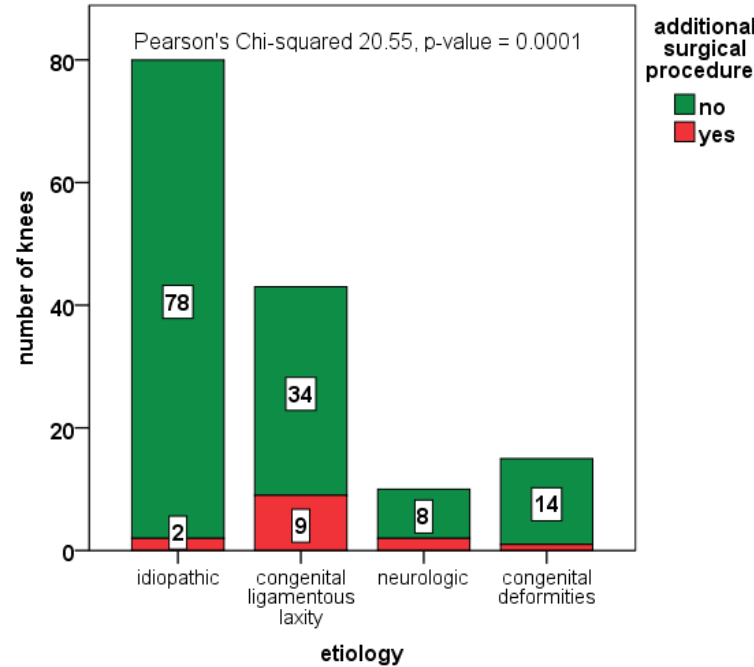
Figure 5. Number of additional surgical procedures (depicted in red) among the different subgroups of patients, based on etiology.